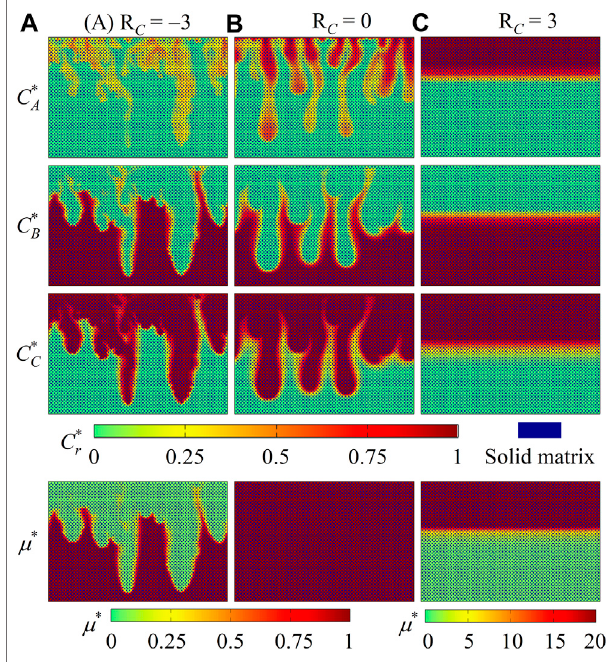
FIGURE 4 | Contours of species concentrations C * r and fl uid viscosity μ * for cases with Ra AB (cid:2) 1, Ra CB (cid:2) 1, and R A (cid:2) 0 and (A) R C (cid:2) − 3 at t * (cid:2) 180, (B) R C (cid:2) 0 at t * (cid:2) 600, and (C) R C (cid:2) 3 at t * (cid:2)